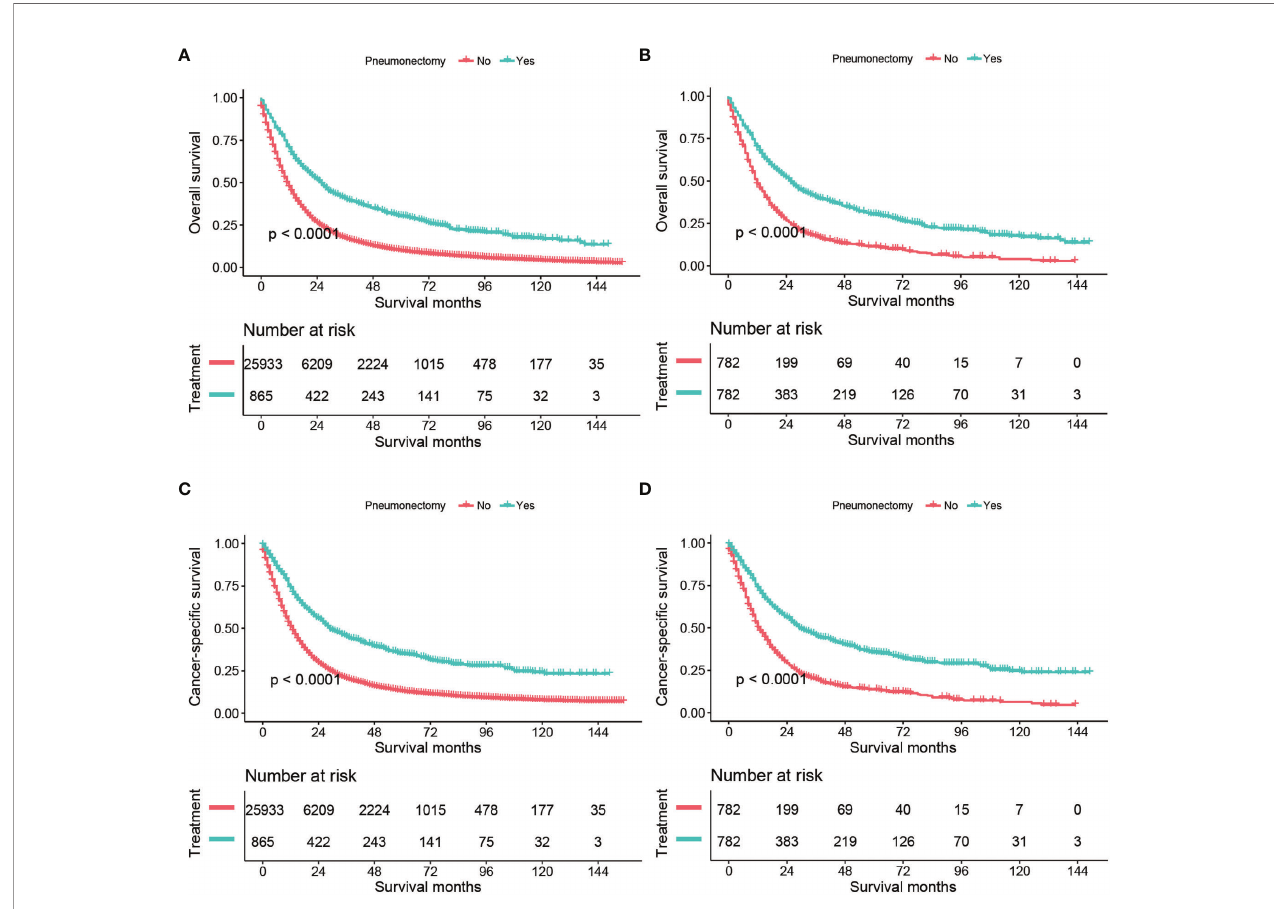
FIGURE 1 | Kaplan – Meier estimates of OS and CSS for stage T1 – 4N2M0 NSCLC patients comparing no surgery with pneumonectomy: OS before PSM (A) , OS after PSM (B) , CSS before PSM (C) , and CSS after PSM (D) . OS, overall survival; CSS, cancer-speci fi c survival; NSCLC, non-small cell lung cancer, PSM, propensity score